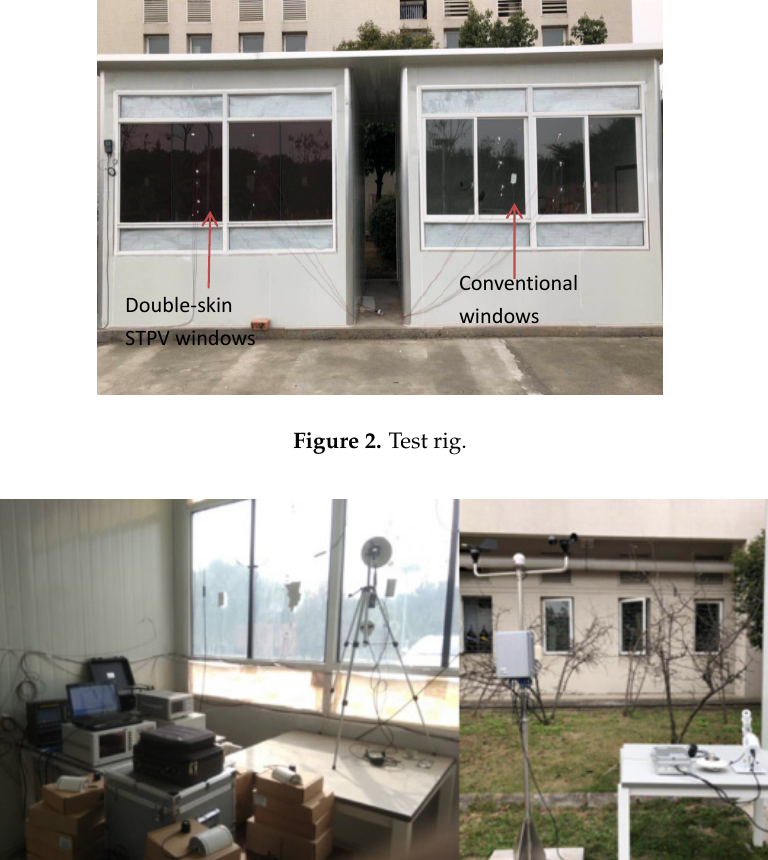
Figure 3. Measurement instruments of the test rig.